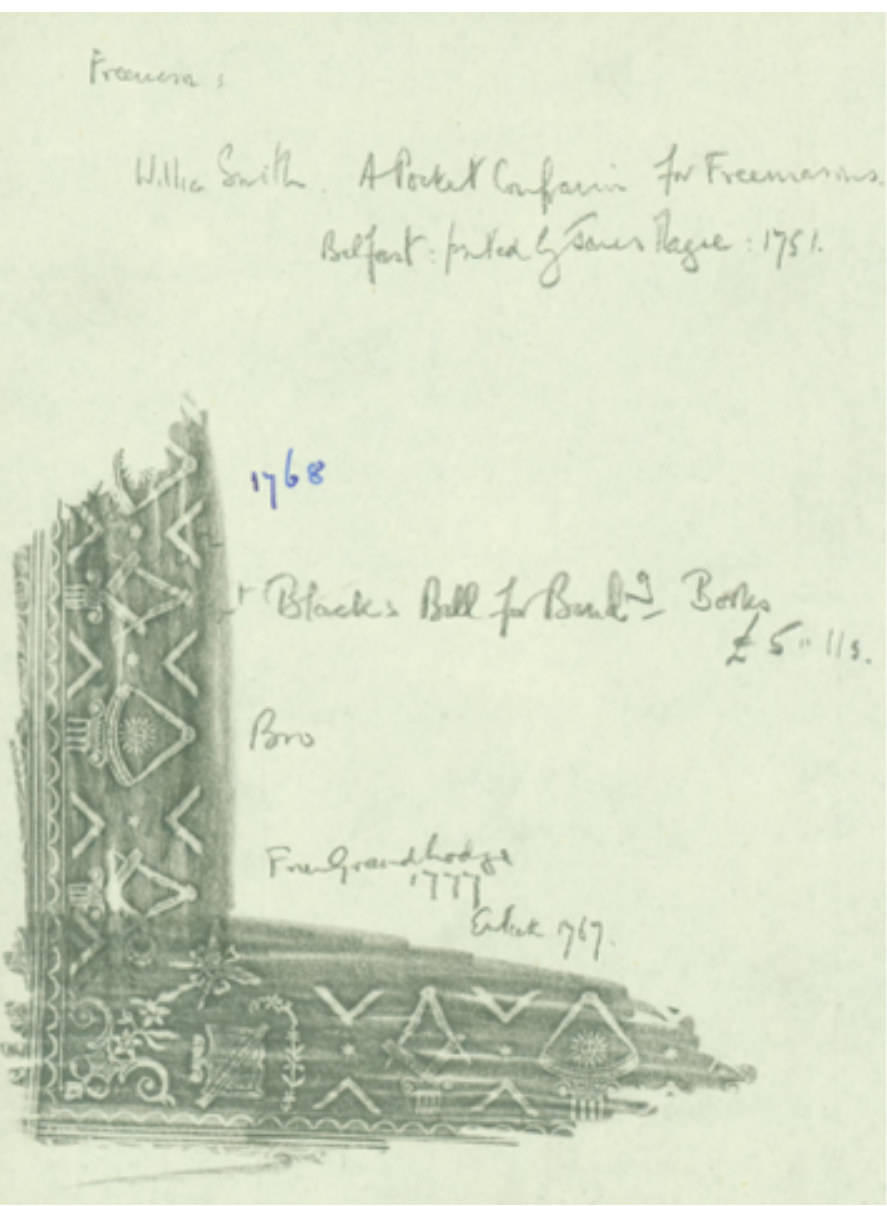
Fig. 33. Howard Nixon’s rubbing of 1767 Book of Constitutions. 111 Note the corner tool and also the placement of the open book with the diagonal ruler. This finisher often places this motif in an unusual alignment.